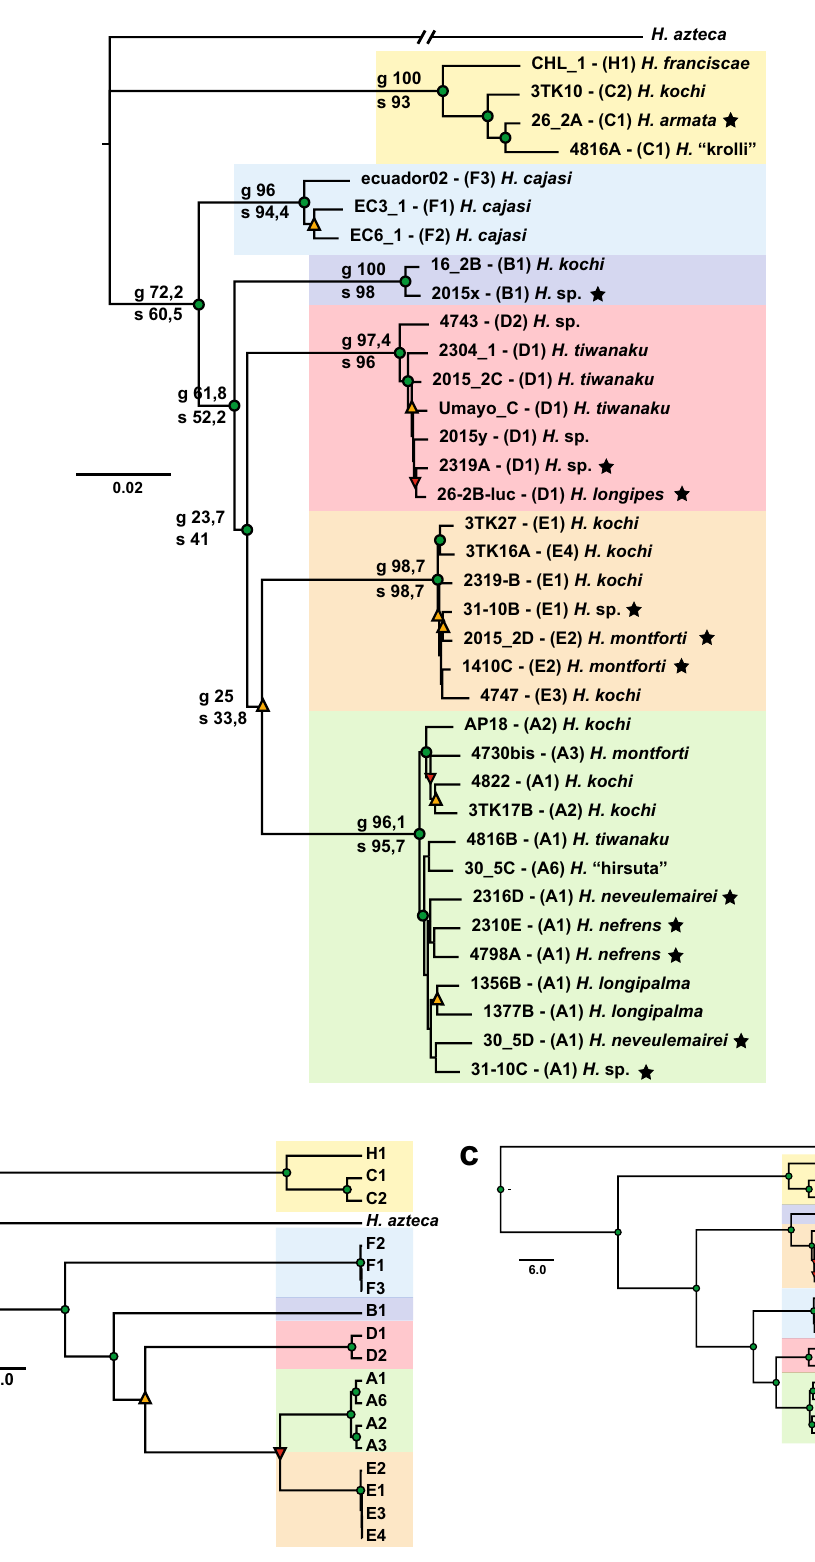
Figure 3. ( a ) Nuclear phylogeny based on the single-copy nuclear genes supermatrix. Node numbers above and below main branches indicate gCF and sFC support values respectively as the proportion of genes (gCF) and sites (sFC) that are concordant with any particular branch in the supermatrix. Code color for ML bootstrap support and stars as in Fig. 2. ( b ) Species tree based on multispecies coalescent model (MSC) using data of the 76 single-copy nuclear gene-fragments. ( c ) MSC tree based on single-copy nuclear gene- fragments plus the 13 mitochondrial protein-coding genes as an extra “gene”. For both ( b , c ) the terminals were classified into species following results by Jurado-Rivera et al. 15 , letters and numbers on tips refer to Molecular Taxonomic Operational Units. Trees are available in nexus format in the GitHub repository (https ://githu b.com/Fraza pel/Hyale lla-amphi pod-Phylo genom ics). Code colour for nodal Bayesian posterior probability values in b) and c) as in Fig.